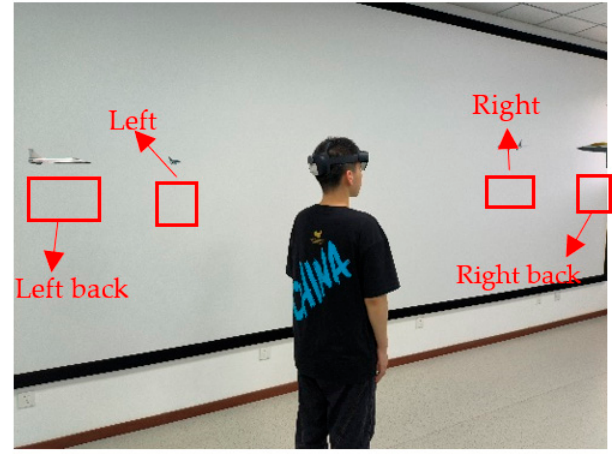
Figure 6. Schematic diagram of the virtual-real scene.